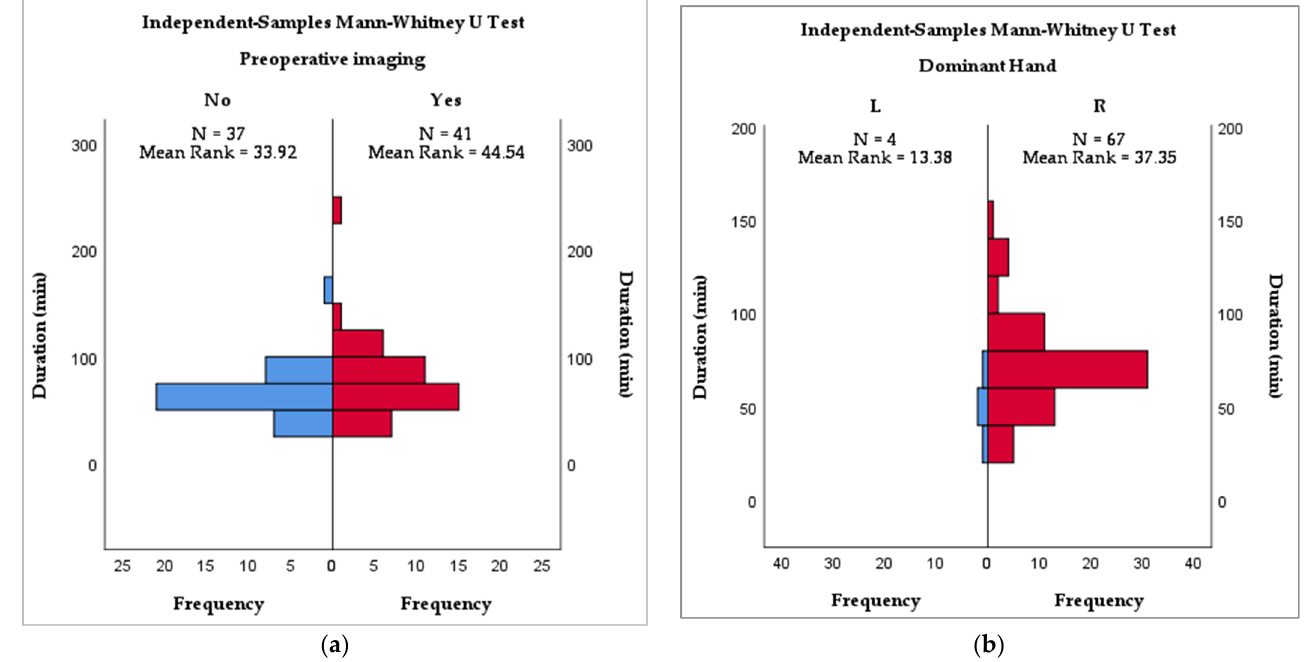
Figure 4. ( a ) Mann–Whitney analysis of preoperative imaging and duration of surgery ( b ) Mann– Whitney analysis of dominant hand of the surgeon and duration of surgery.